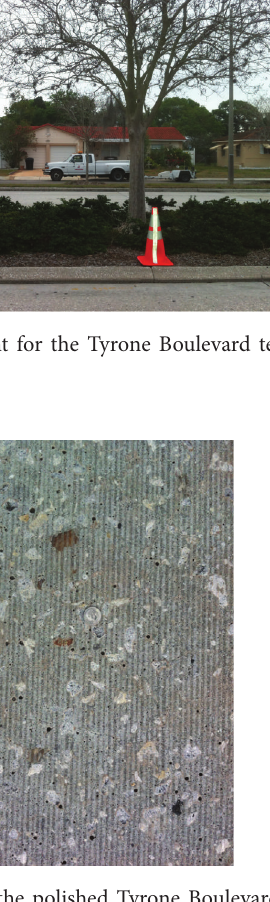
Figure 15: Close-up of the polished Tyrone Boulevard pavement showing the longitudinal tining.